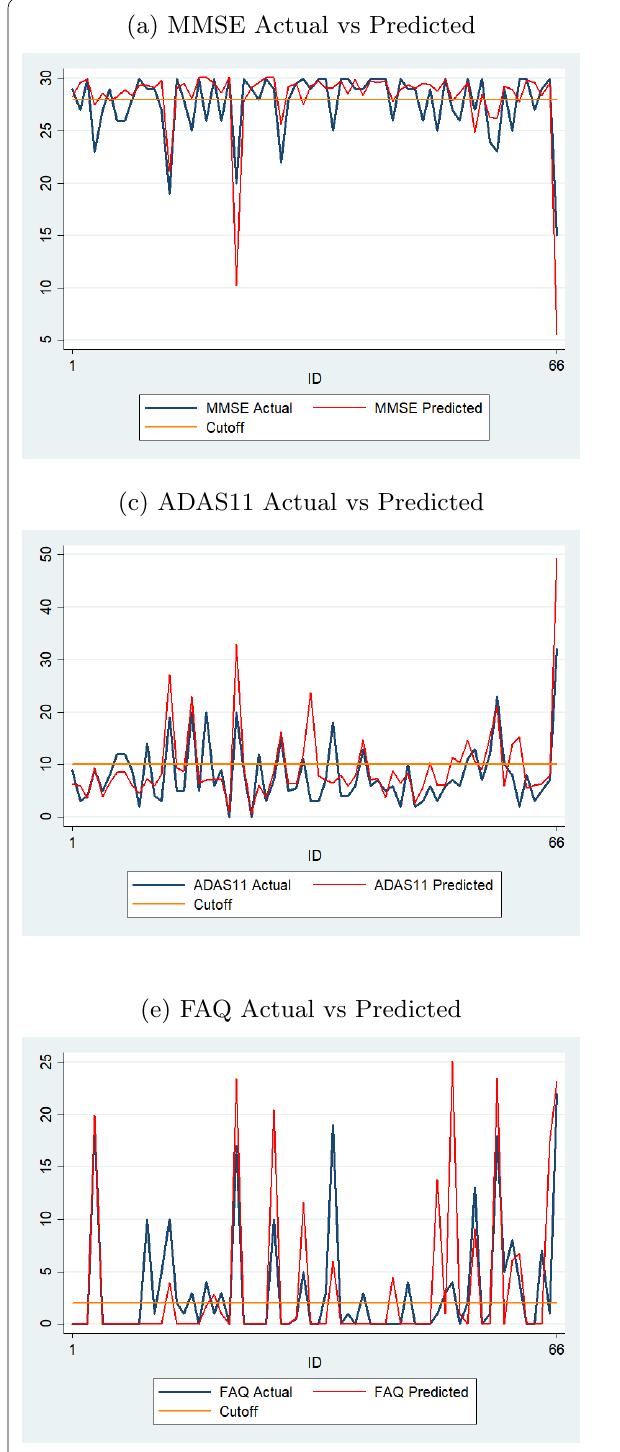
Fig. 12 Comparison of actual and predicted values by sequence prediction models at month 72 for 66 test dataset subjects (with normal